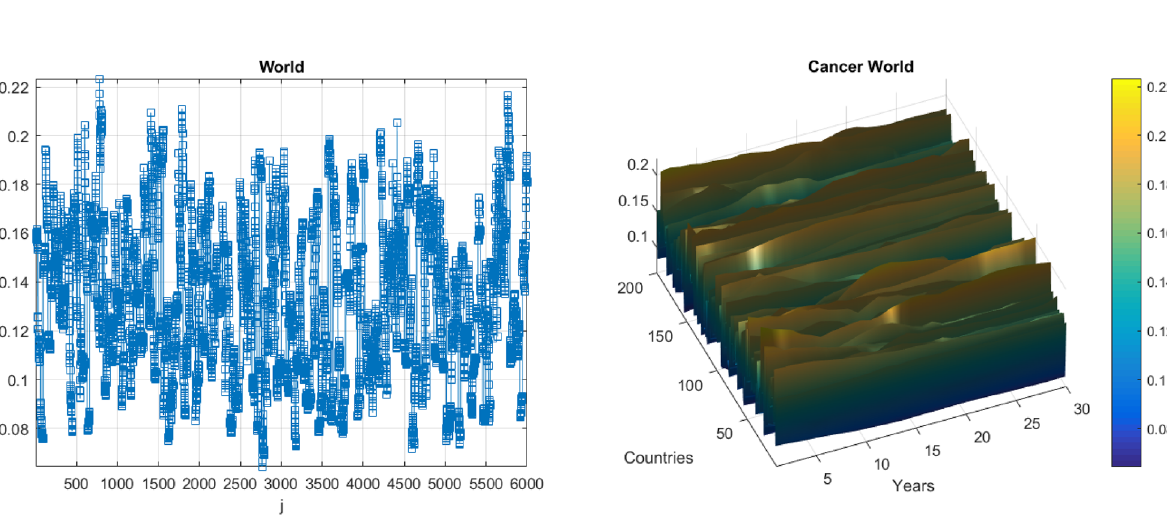
Figure 3. Annual cancer annual death cases. Left: as % of local population per country and year. Right: in per −→ R . Scaled by Eq. (9) in per cent of the corresponding country population. cent as 195D vector